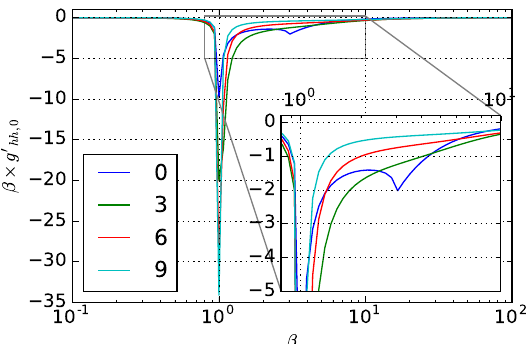
Figure 3. 0th-order weighting function magnitude with respect to dielectric constant for materials with n r = 3. The legend in the figure shows the corresponding k value for each curve. Inset plot corresponds to the boxed